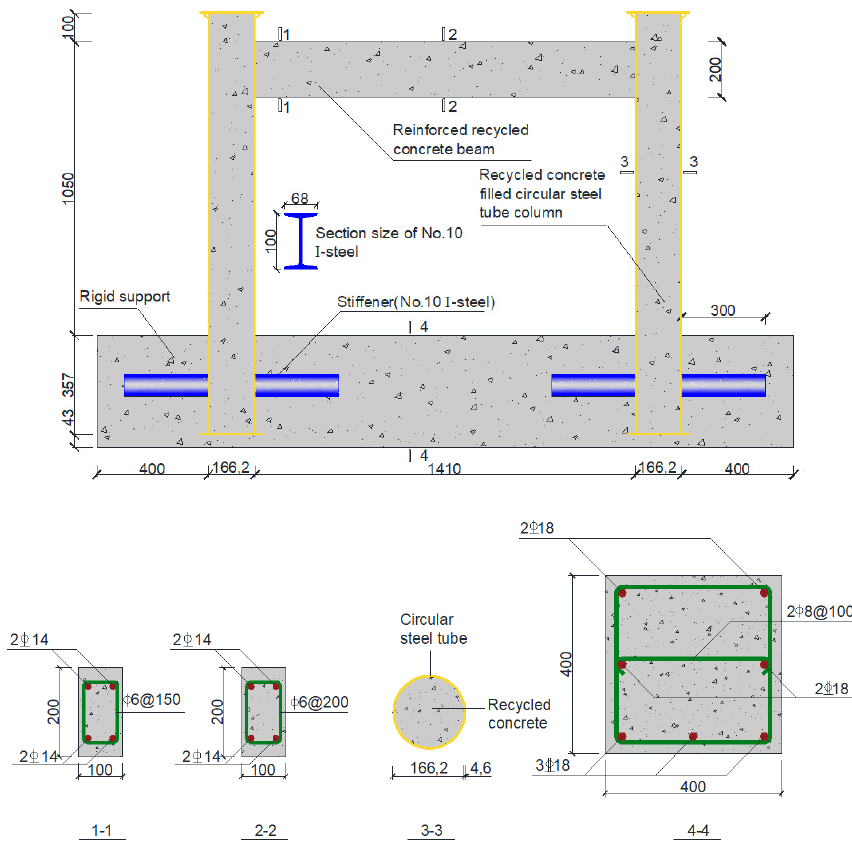
Figure 1. Specimen configuration and reinforcements.